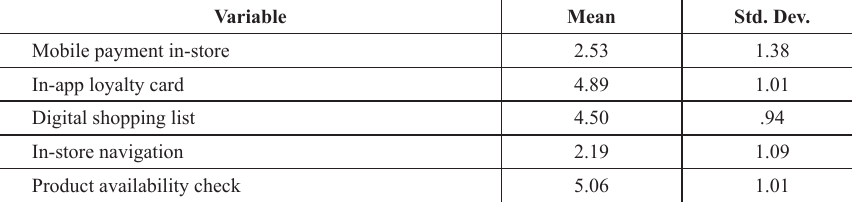
Table 2. Descriptive data of cluster 2 (N = 36)